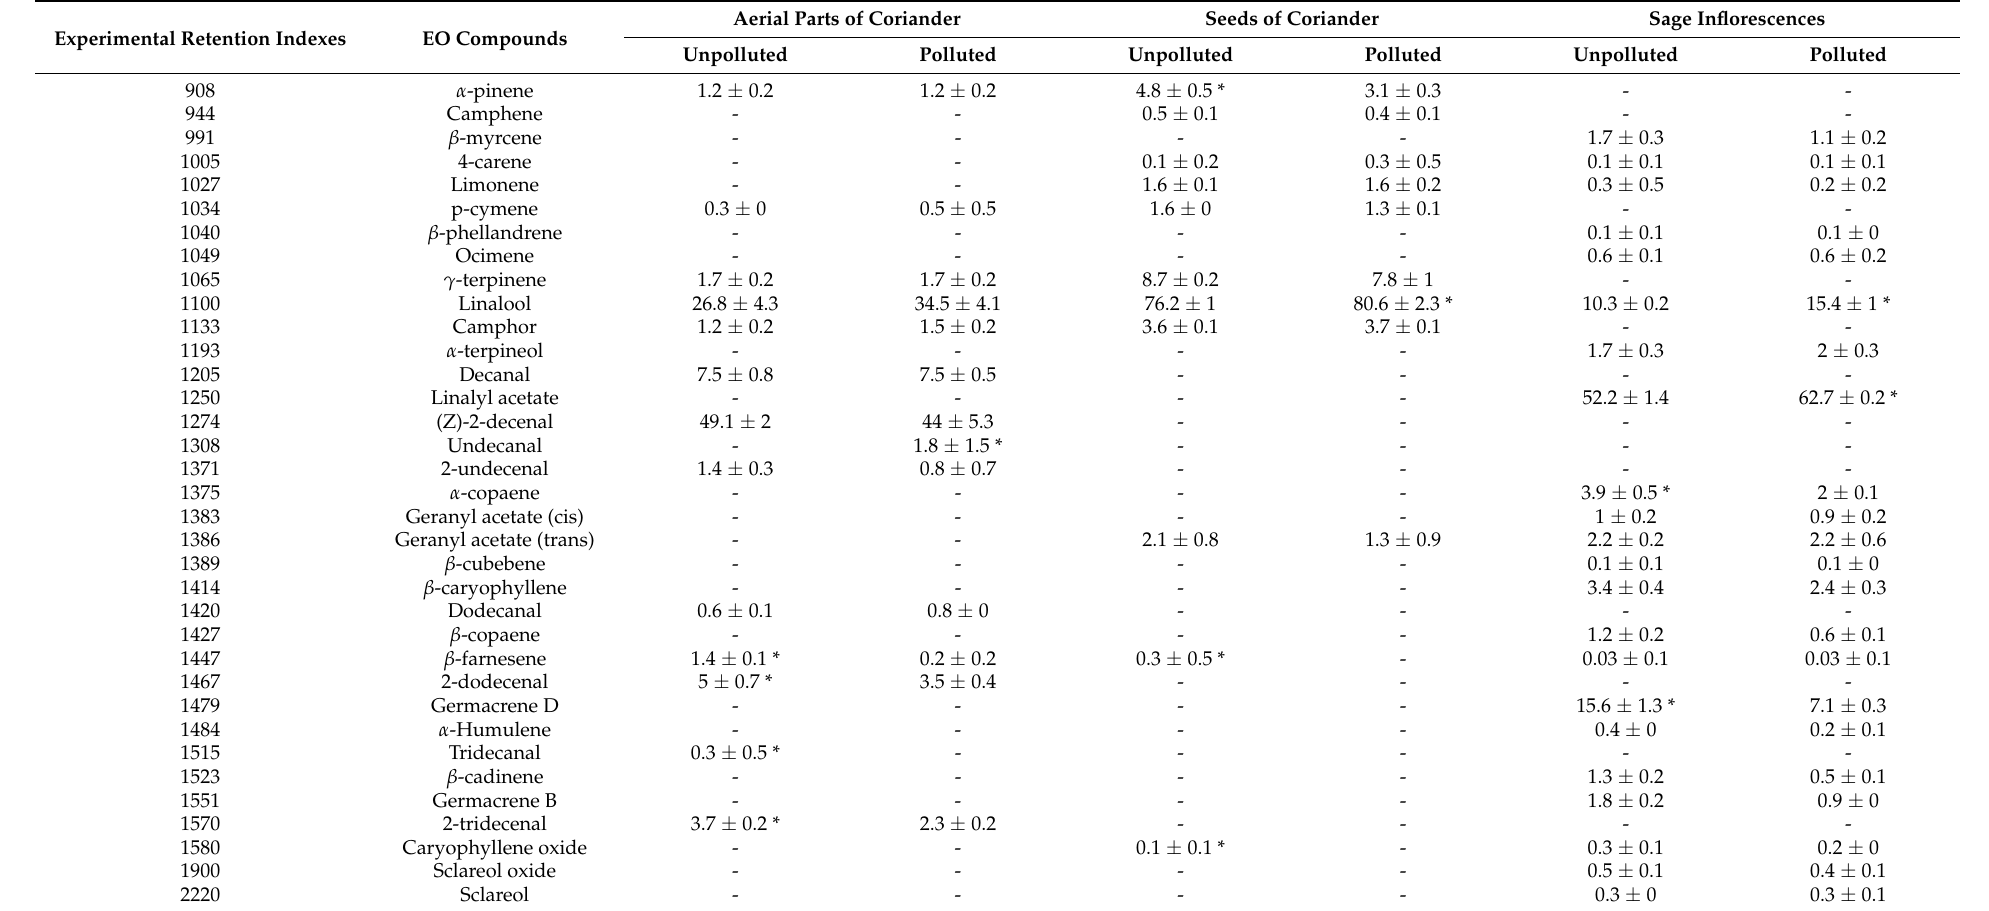
Table 1. Chemical composition of the EO from aerial parts or seeds of coriander, and from sage inflorescences, grown on unpolluted or TE-polluted sites. Data are relative percentages of EO compounds, expressed as means ± SD (n = 3). For a same plant part, means followed by an asterisk “*” are significantly different, between polluted and unpolluted conditions, by one-way ANOVA test ( α =